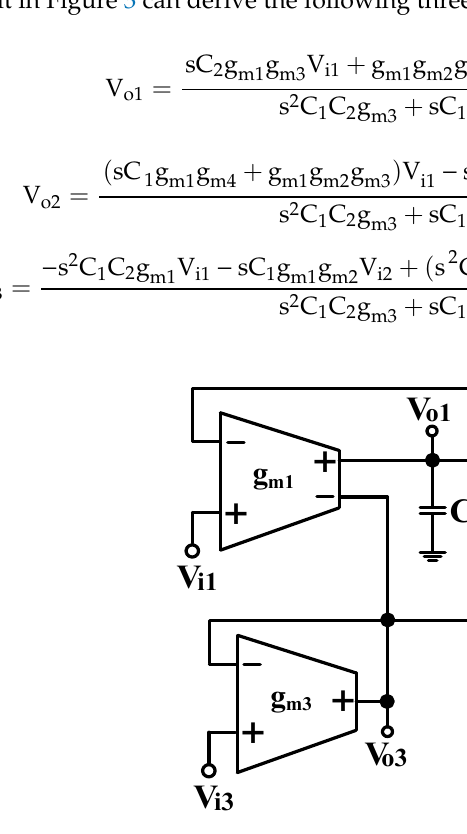
Figure 3. Proposed versatile VM biquad.